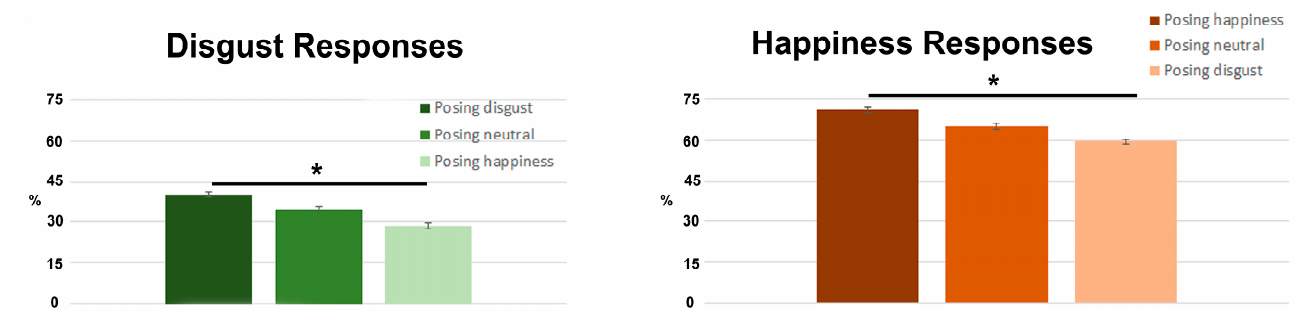
Figure 2. Behavioral results. Left: % of disgust responses for participants posing disgust/neutral/happiness expression. Right: % of happiness responses for participants in happiness/neutral/disgust expression. * = p < 0.005, bars = standard errors.